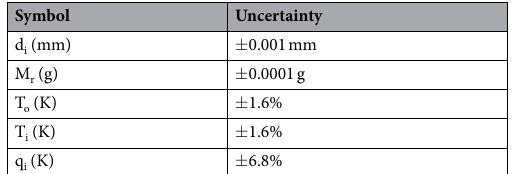
Table 3. Summary of the uncertainty.